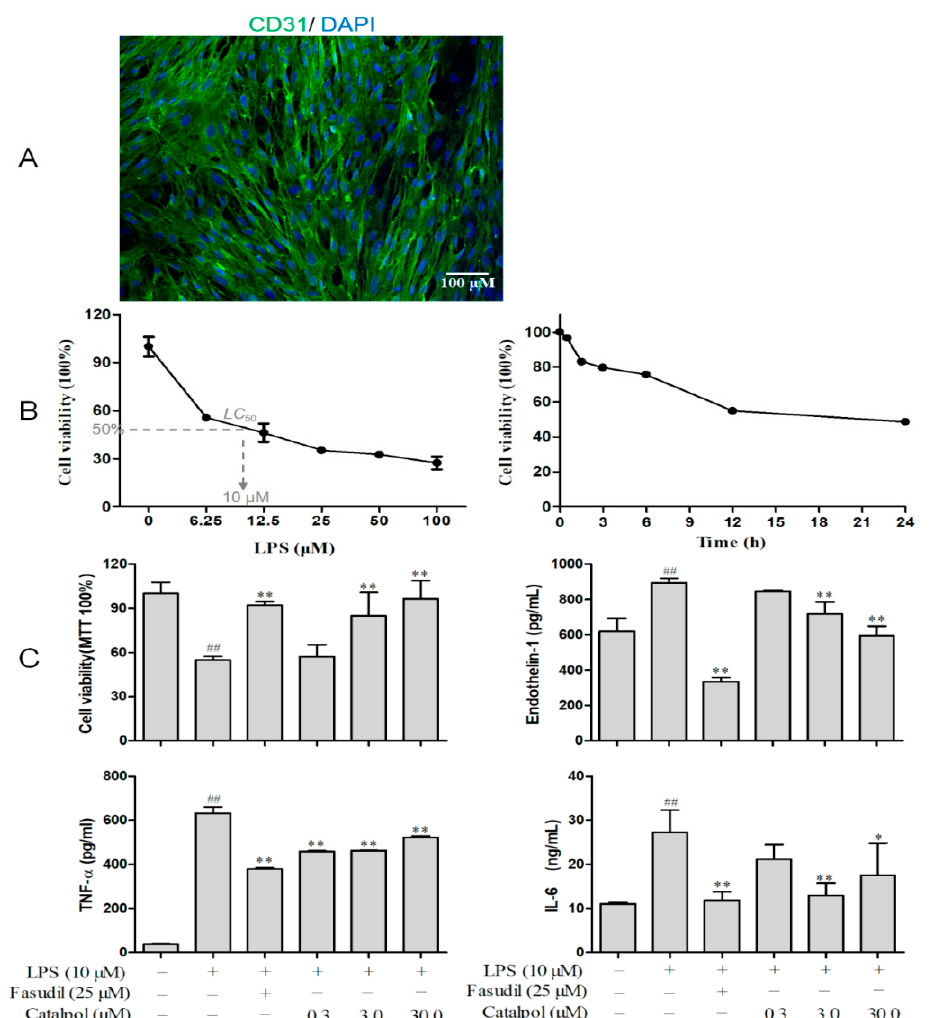
Figure 4. Catalpol improved BMEC survival and its secretory function on endothelin-1 and inflammatory cytokines. ( A ) BMECs characterization via immunocytochemical staining with FITC labeled CD31. ( B ) LPS concentration and treatment time screening. ( C ) The effects of catalpol on cell survival rate (MTT test), endothelin-1, TNF- α and IL-6 secretion of LPS injured BMECs. ( ± SD, n = 6), ## p < 0.01 vs. the control group; * p < 0.05, vs. the model group; ** p < 0.01, vs the model group. BMECs, brain microvascular endothelial